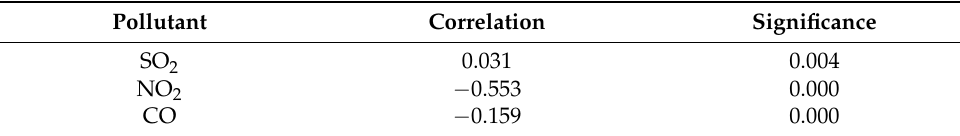
Table 4. Correlation analysis between O 3 concentration and pollutants.